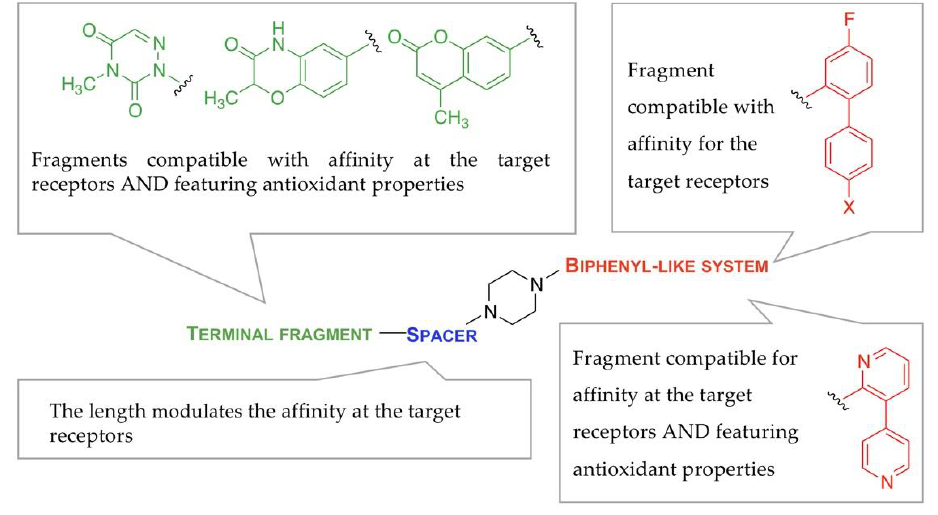
Figure 2. Design Strategy for the Target Compounds. Table 1. Lipophilicity (cLogP), CNS MPO, and Metabolic Stability (MS) of the Target Compounds.